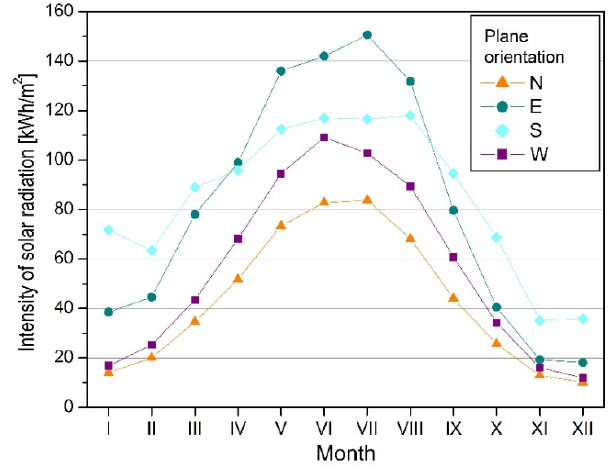
Figure 6. Solar radiation on vertical planes, calculated according to Perez model. Table 5. Solar radiation intensity on the vertical planes of different orientations (blue marks the lowest sums and yellow marks the highest).